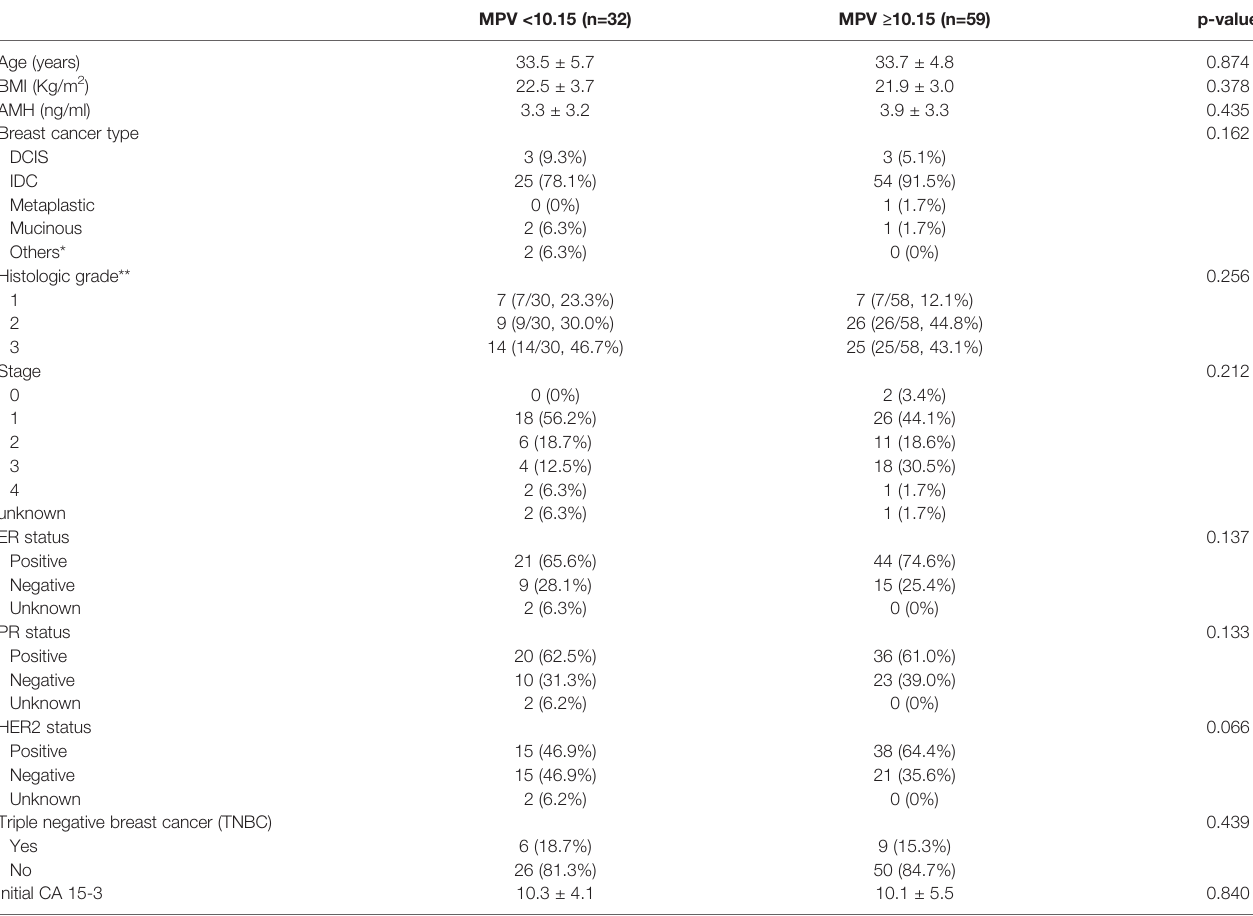
TABLE 2 | Basal characteristics of patients with breast cancer at the MPV cutoff value 10.15